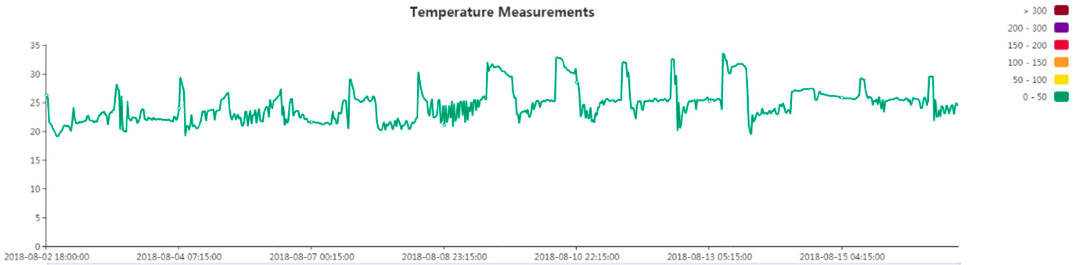
Figure 10. Indoor Temperature.